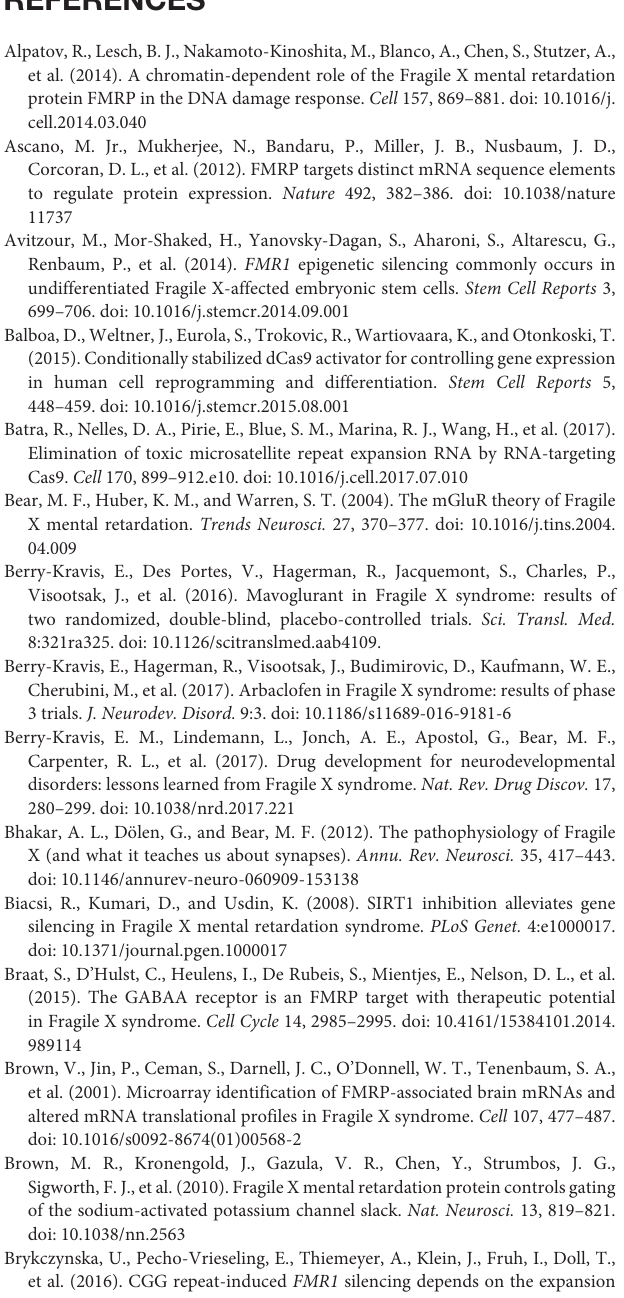
types of evidence computed by iPathwayGuide using Impact Analysis (Tarca et al., 2009): over-representation on the x -axis (pORA-Over Representation Analysis) and the total pathway accumulation on the y -axis (pAcc: Accumulated perturbation of the pathway). Each pathway is represented by a single dot, with significant pathways shown in red, non-significant in black. Both p -values are shown in terms of their negative log (base 10) values. Yellow dot represents cancer pathways. The adjacent red dots show pathways for melanoma and breast cancer. Figure obtained from iPathwayGuide (http://www.advaitabio.com/ ipathwayguide). TABLE S1 | List of all primers used to construct sgRNA plasmids and for qPCR analysis in this